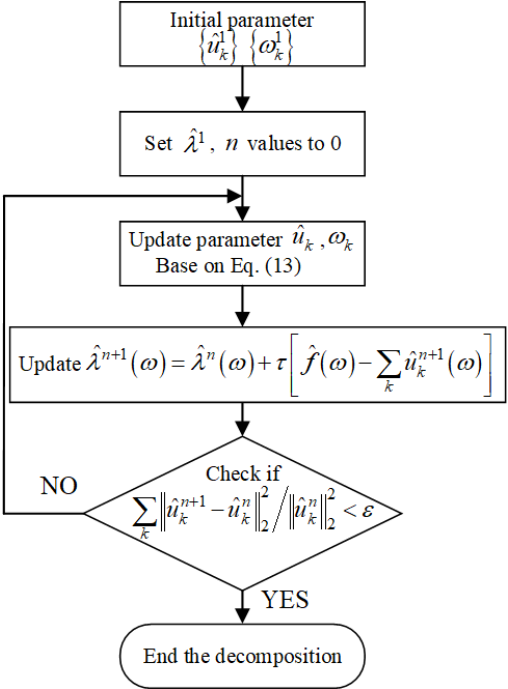
Figure 1. Flow chart of the VMD algorithm.